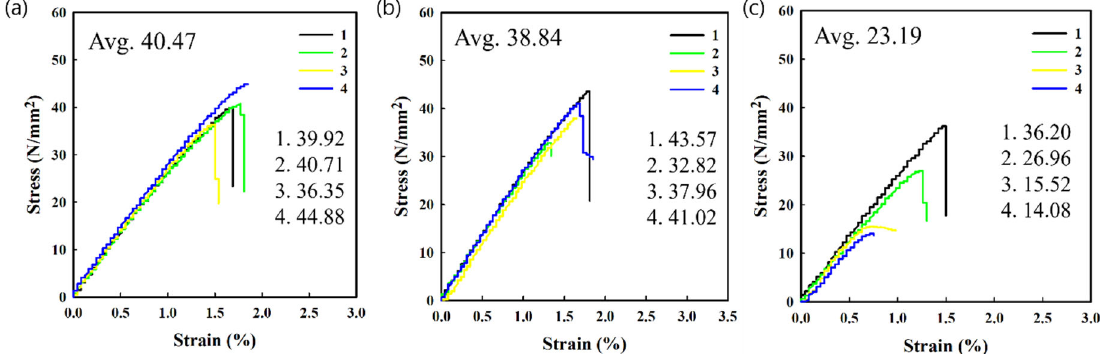
Figure 4. Stress–strain curves for ( a ) pristine, ( b ) one ‐ time recycled, and ( c ) three ‐ time recycled specimens fabricated vertically.